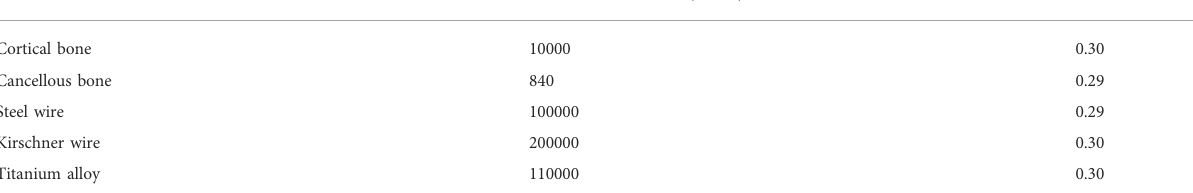
TABLE 2 Model material parameters.